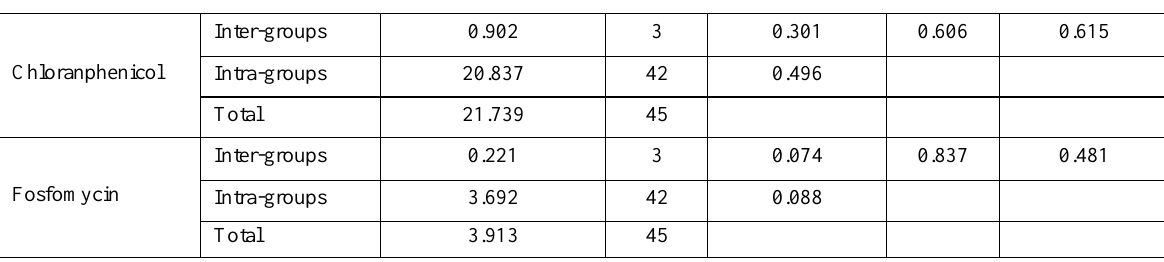
Table 3: Distribution of multidrug-resistant isolates (MDR-type multidrug-resistant) Escherichia coli Pseudomonas spp. Staphylococcus aureus Salmonella spp. Families